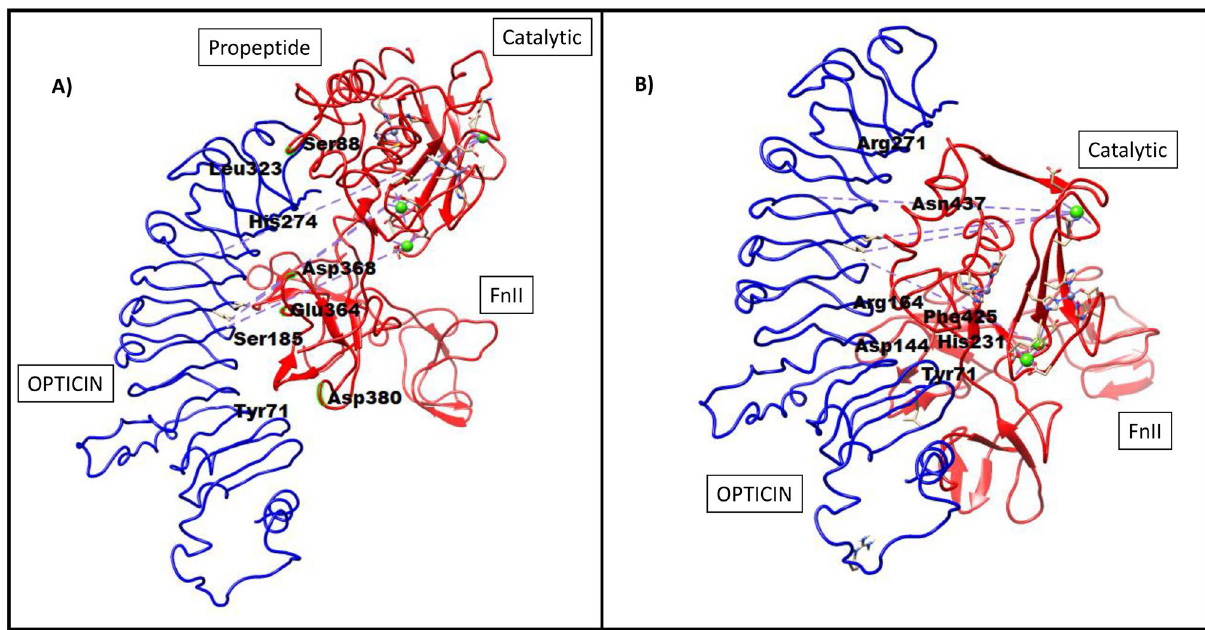
Figure 2. Predicted interactions of opticin with pro-MMP9 ( A ), and active MMP9 ( B ) using PatchDock. The important amino acids involved in these interactions at the predicted sites are shown in bold black